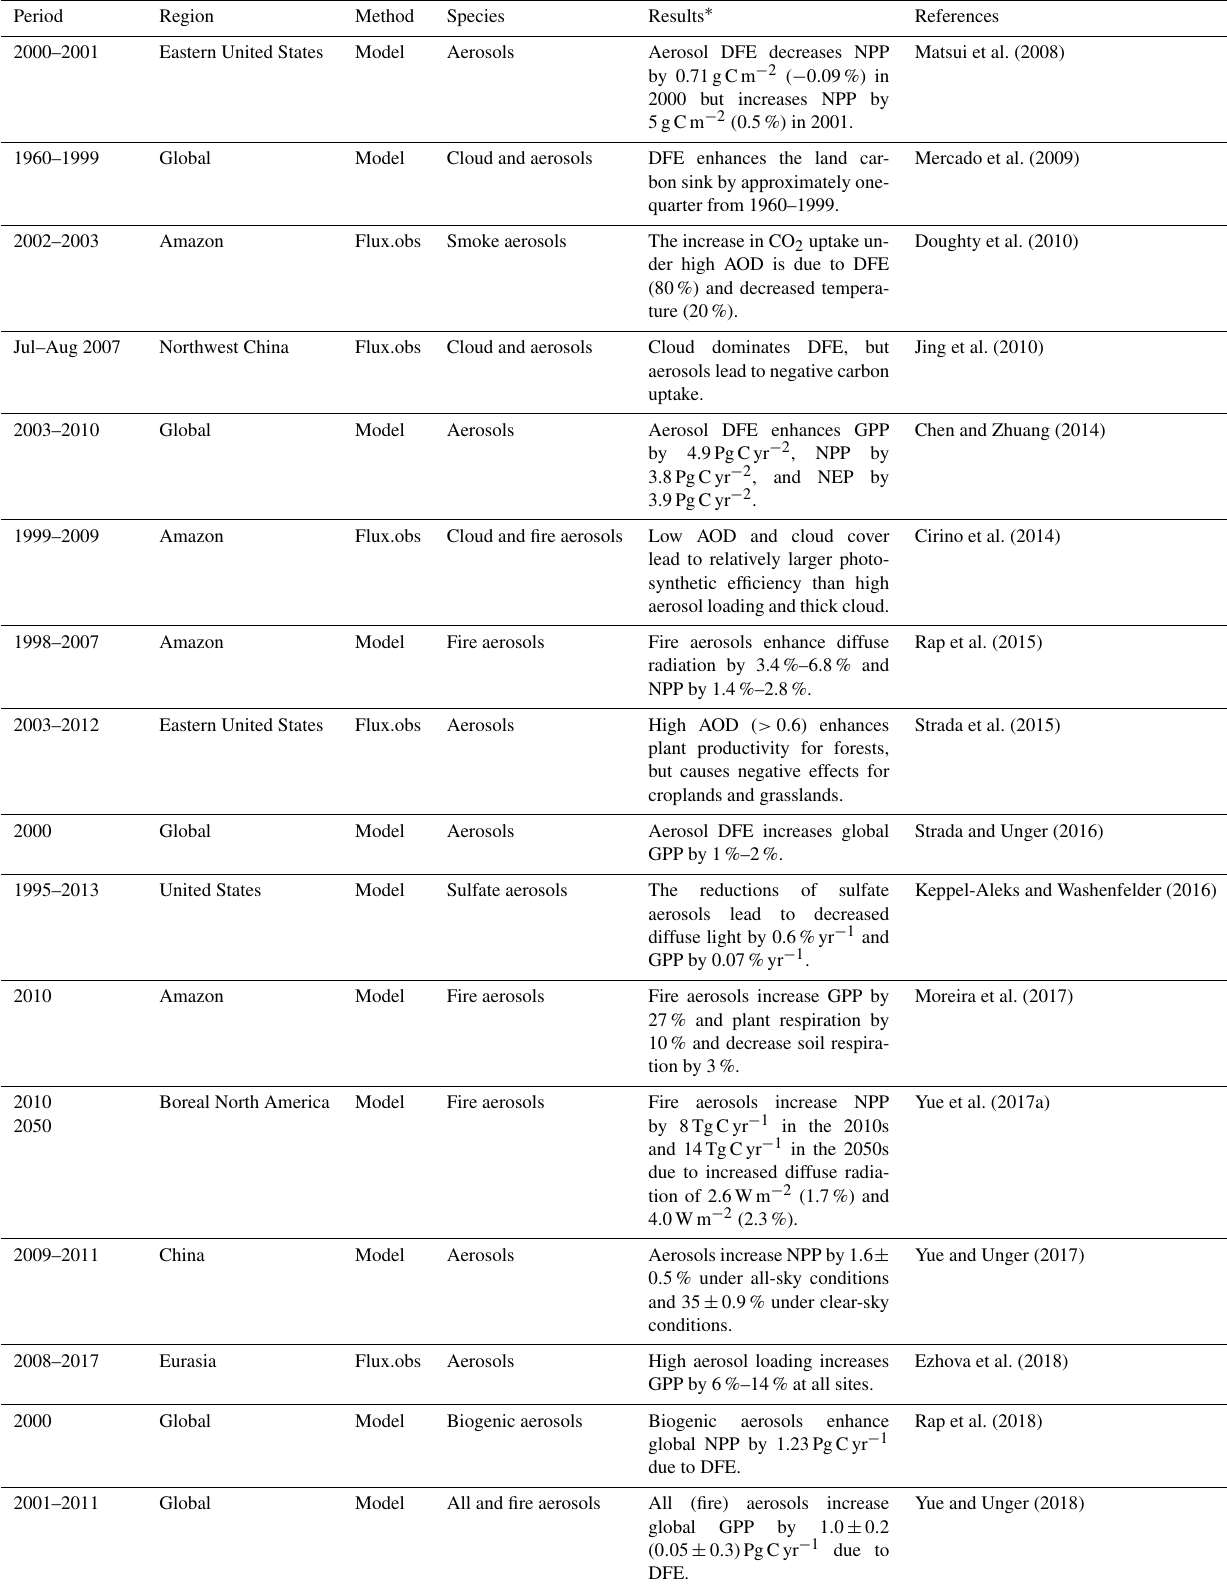
Table 1. Summary of previous studies about aerosol DFE.